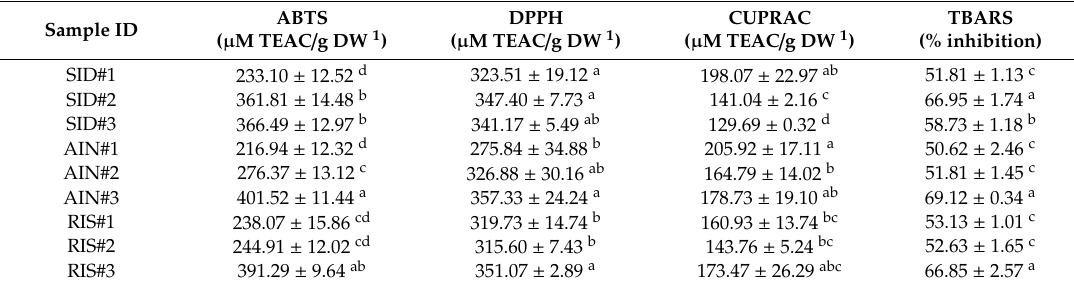
Table 8. Variations in in vitro cell free (ABTS, DPPH and CUPRAC) and cellular (TBARS) antioxidant potential of extracts obtained from USAE of AOR from three di ff erent native Beldi genotypes produced at three di ff erent pilot locations in Eastern